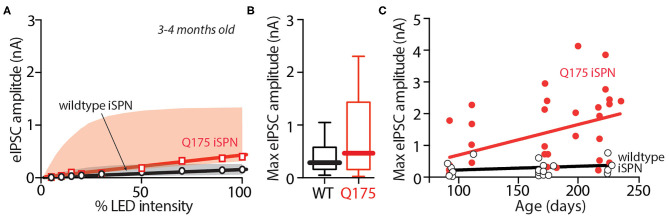
In zQ175+/− mice, iSPN-ChI GABA signaling is enhanced in 6–9 month old mice, but not in 3–4 month old mice. (A) Summary of input - output relationship of eIPSC amplitude at the iSPN-ChI synapse at progressively higher stimulation intensities in young zQ175+/− (red) and WT (black) mice. (B) Box plots of maximum eIPSC amplitude in WT and zQ175+/− mice aged 3–4 months showing no significant statistical difference between genotypes. (C) Maximum eIPSC amplitude increases linearly with age in ChIs from zQ175+/− mice, but not in ChIs from WT mice.